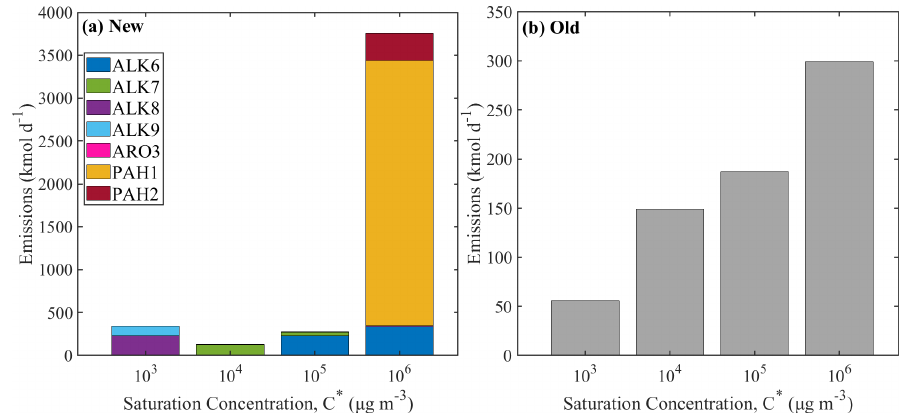
Figure 6. The volatility distribution of the IVOC emissions from on-road gasoline vehicles (a) using the new lumped species approach and (b) using the old VBS approach. Different axes are used for the two distributions.